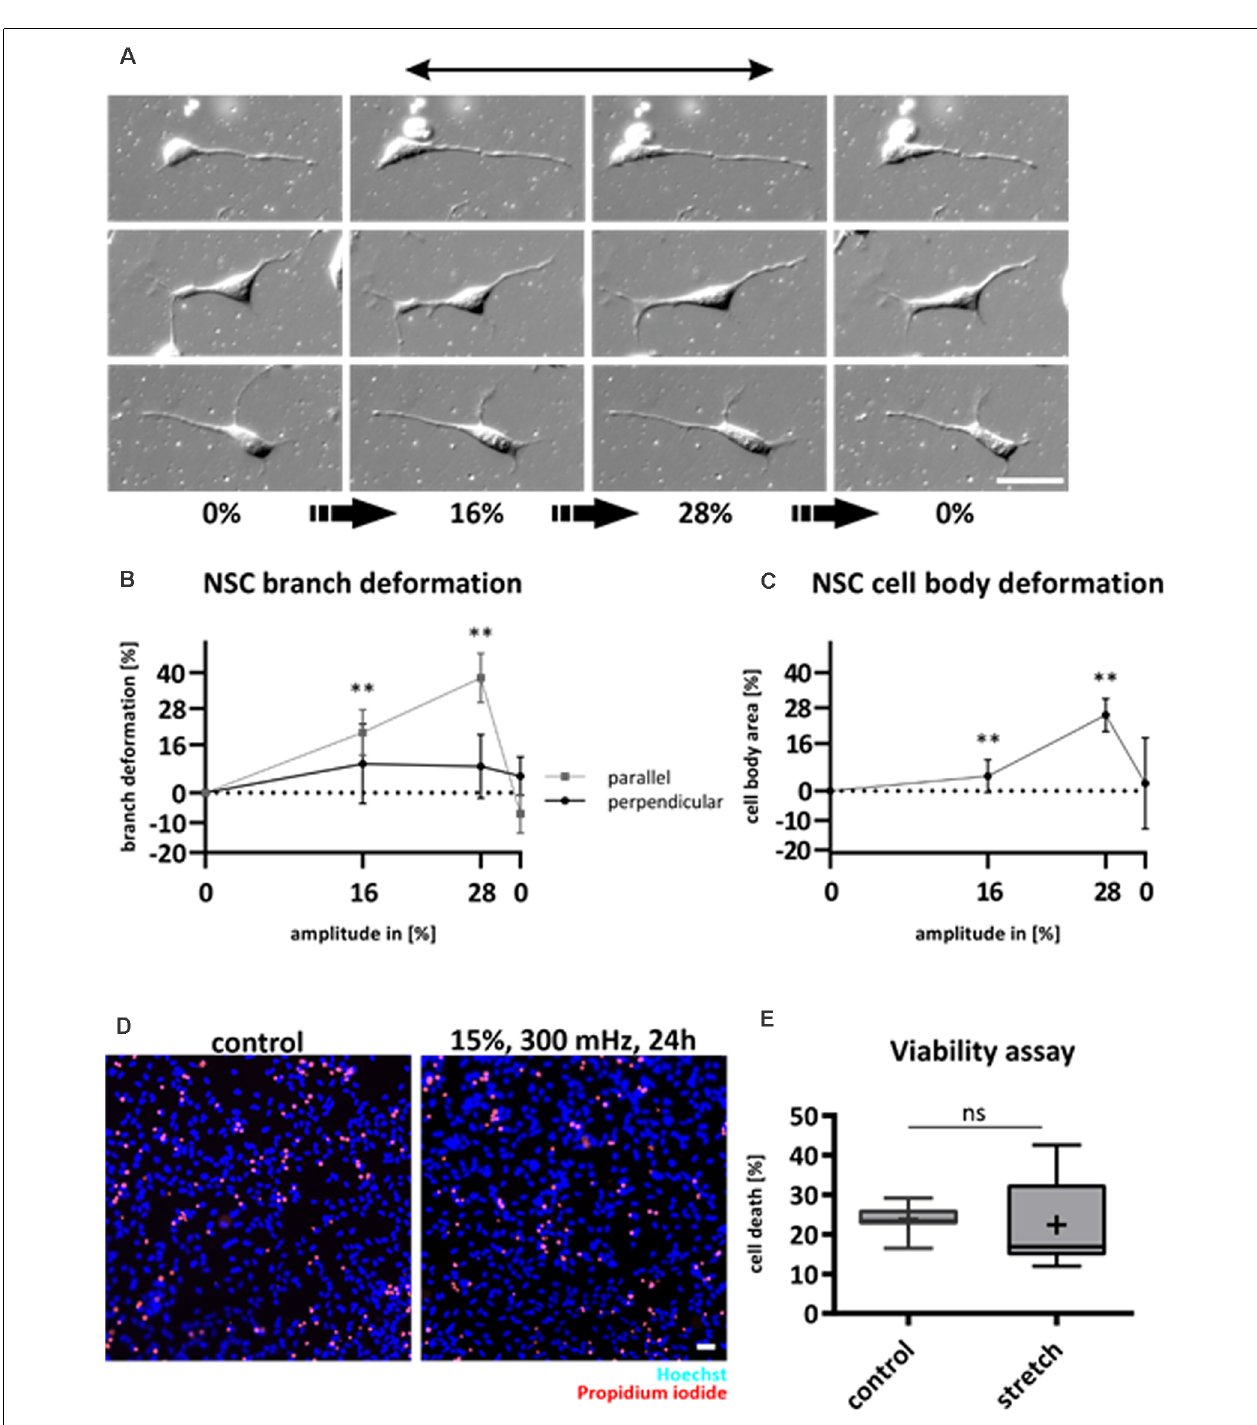
FIGURE 1 | NSCs follow substrate deformation and are unaffected by cyclic strain. NSCs were stretched statically and observed via DIC live-cell microscopy to assess cell morphology changes caused by substrate (A) . Mechanical strain was increased stepwise by an amplitude of 4% and at a velocity of 0.5 mm/s. After reaching 28%, the stretch was released from the system. The black arrow indicates the strain direction. Deformation of NSC branches (B) . Deformation of NSC cell bodies (C) . The plots in (B) and (C) represent n = 5 chambers per parameter with at least 40 analyzed cells for each experiment. NSC branches that point in stretch or perpendicular direction were analyzed separately (p-value of parallel branches 0% vs. 16%: 0.008; 0% vs. 28% 0.008; p-value of cell bodies: 0% vs. 16%: 0.008; 0% vs. 28%: 0.008). Live/Dead assay of NSCs subjected to substrate strain compared to control (D) . Dead cells were stained with propidium iodide (red) and counted relative to the number of all cells stained with Hoechst (blue). The values are represented as box plots (E) , the black line shows the median, and the cross indicates the mean ( n = 7 chambers from four different passages, ns = non-significant). Scale bars = 20 µ m. ∗ define significant differences (see “Material and Methods”